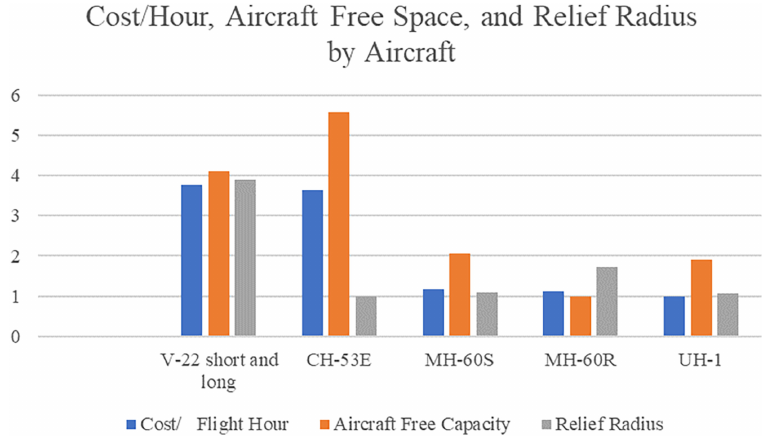
Figure 3. Cost/hour, aircraft